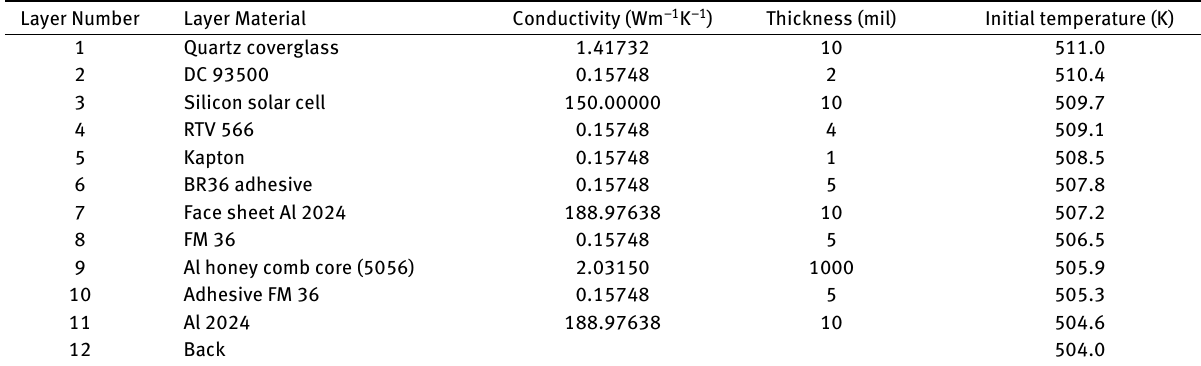
Table 3. Materials and characteristics of each layer of GPS Block IIR solar panels Layer Number